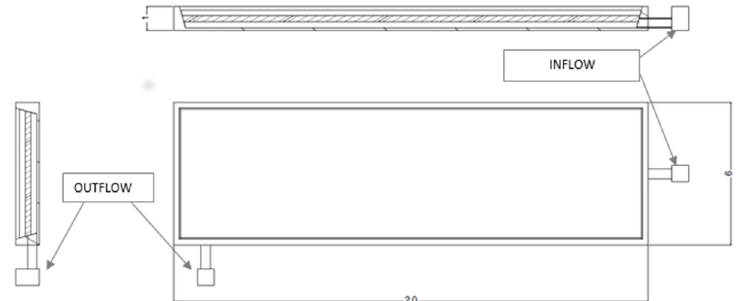
Figure 1. Design of the constructed wetland.